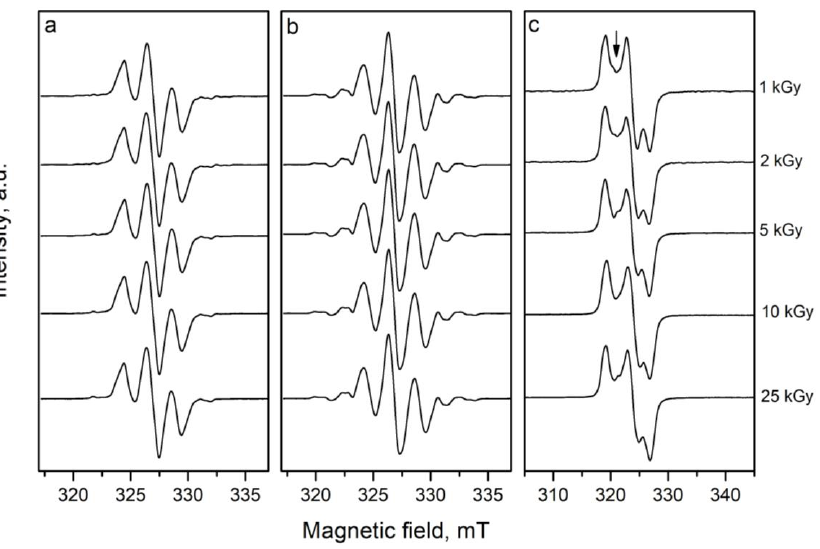
Figure 3. Effect of the dose on the shape of the EPR spectra: ( a ) L-proline, ( b ) DL-proline, and ( c ) cysteine.